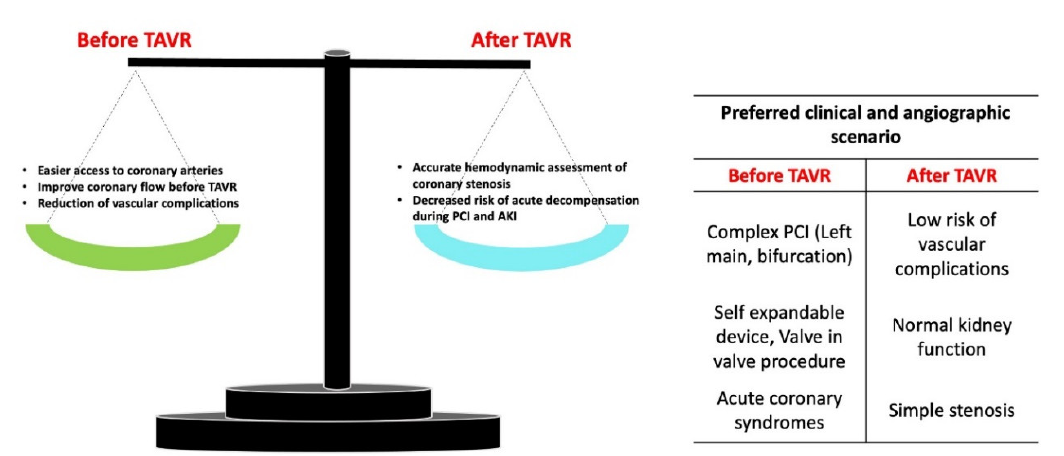
Figure 2. Advantages and disadvantages of performing PCI before or after transcatheter aortic valve replacement. PCI: percutaneous coronary intervention; AKI: acute kidney injury.